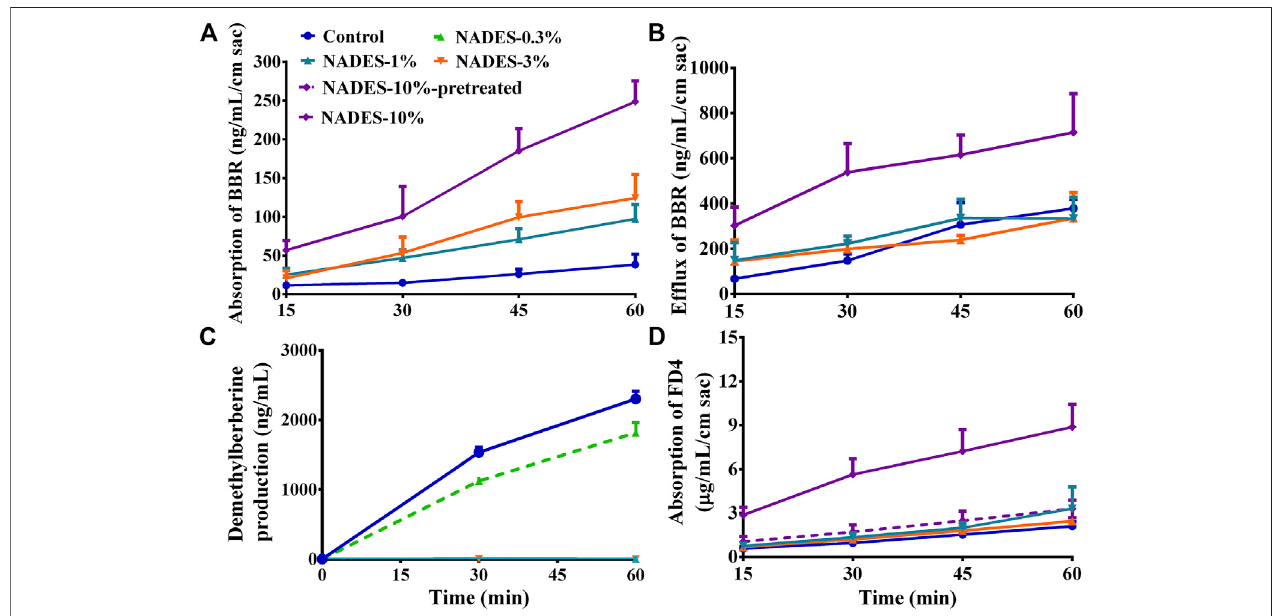
FIGURE 3 | Studies in mouse gut sacs and intestinal S9 (Mean ± SD, n (cid:2) 3). (A,B) , effects of the dilutions (1, 3, and 10%) of the natural deep eutectic solvent (NADES)ontheabsorptionandef fl uxofberberinehydrochloride(BBR,200 μ g/ml)inmousegutsacs,respectively; (C) ,effectsofthedilutions(0.3and1%)oftheNADES onthemetabolismofBBR(10 μ g/ml)inintestinalS9; (D) ,effectsofthedilutedNADES(1,3,and10%)andpretreatmentwith10%NADESfor4 honthetransportationof fl uorescein isothiocyanate-labeled dextran (FD4, 3 mg/ml) in mouse gut sacs.